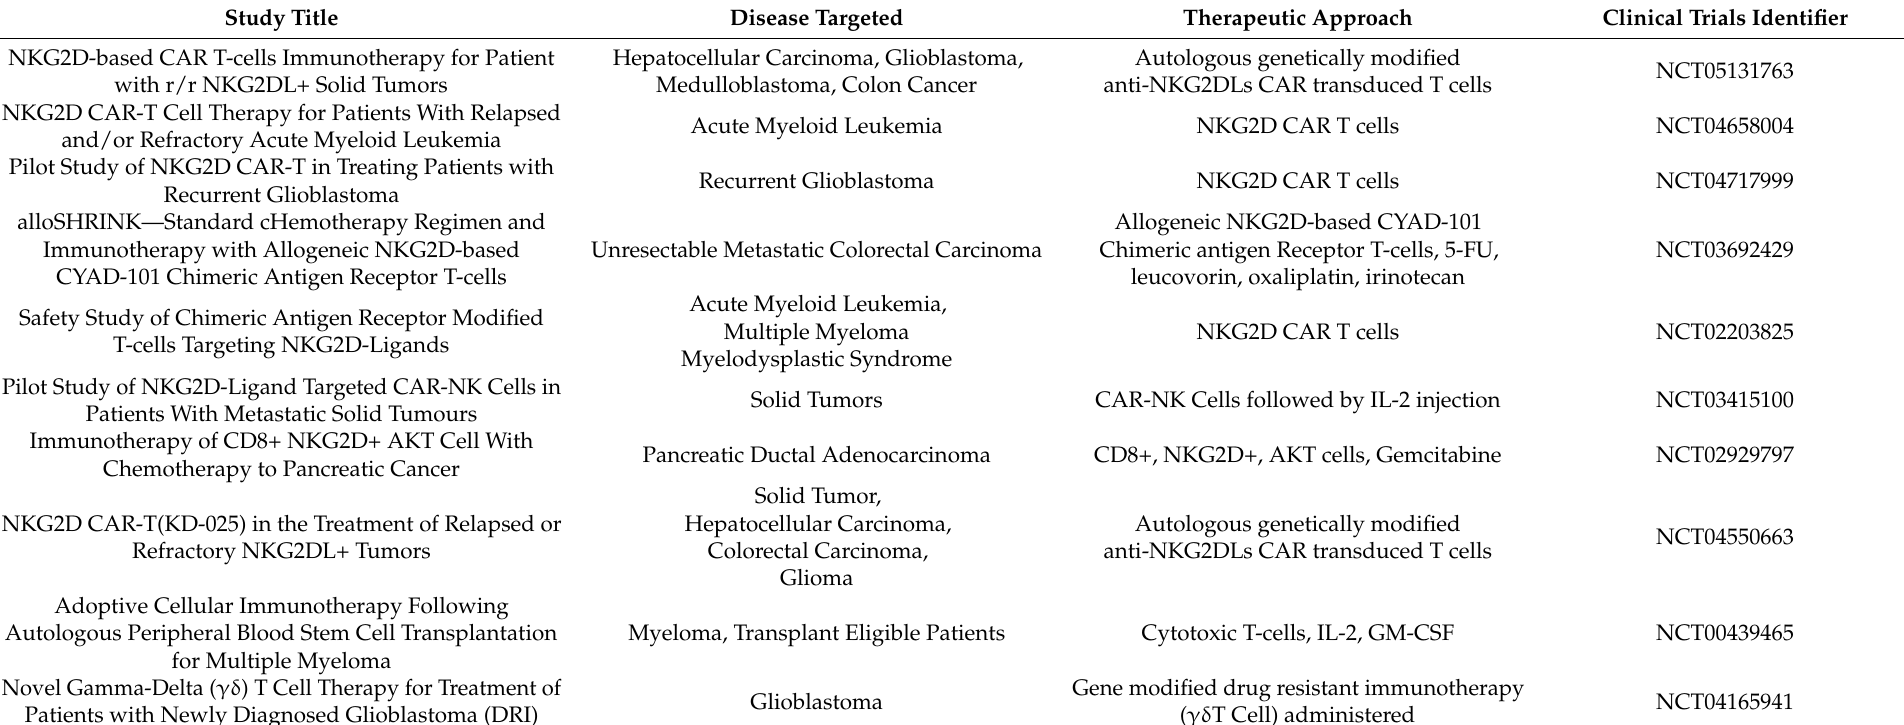
Table 1. Current clinical trials utilizing the NKG2D stress response